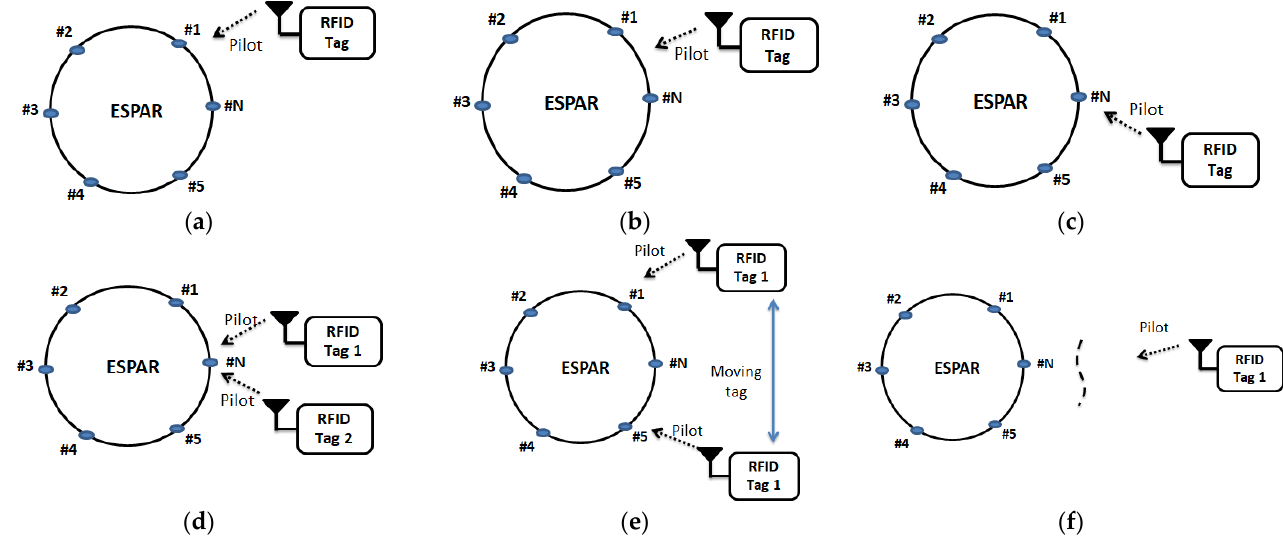
Figure 12. Passive elements of the ESPAR antenna decide the tag’s direction: ( a ) passive element #1 decides the tag’s direction; ( b ) decision of the tag’s position is selected by passive elements #1 or #N; ( c ) tag position is decided by element #N set configuration; ( d ) two pilots of the separate tags coming toward the parasitic element #N; ( e ) the tag’s location decision during moving; ( f ) when the tag is farther from the ESPAR antenna or due to the obstacle, the RSS at the parasitic elements is affected